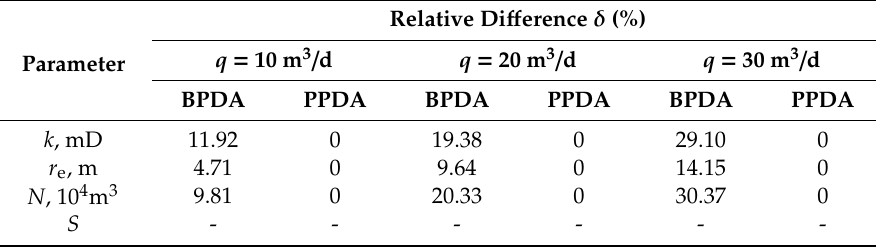
Table 7. Relative di ff erences between the actual values and estimated values for CRP